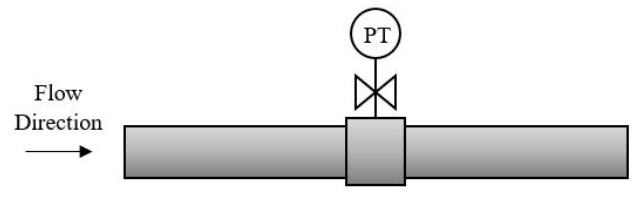
Figure 8. A PT sensor placed on a pipe. The PT sensor is replaced without causing any affection on the oil production due to the location of the valve.